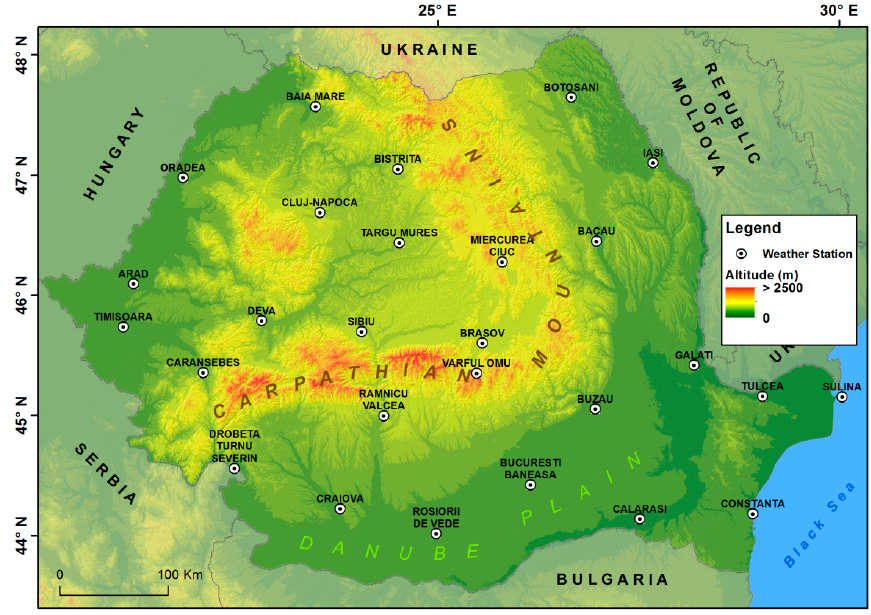
Figure 1. Location of weather stations used for this study.